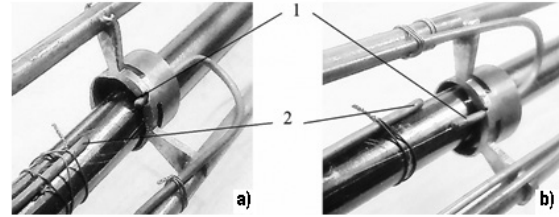
Figure 2. TET hot junction attachment points: а ) – in the SG plane ; b) – 7 mm above the SG plane; TET forced against the SG cladding (1), TET forced against the cladding by means of wire binding (2)